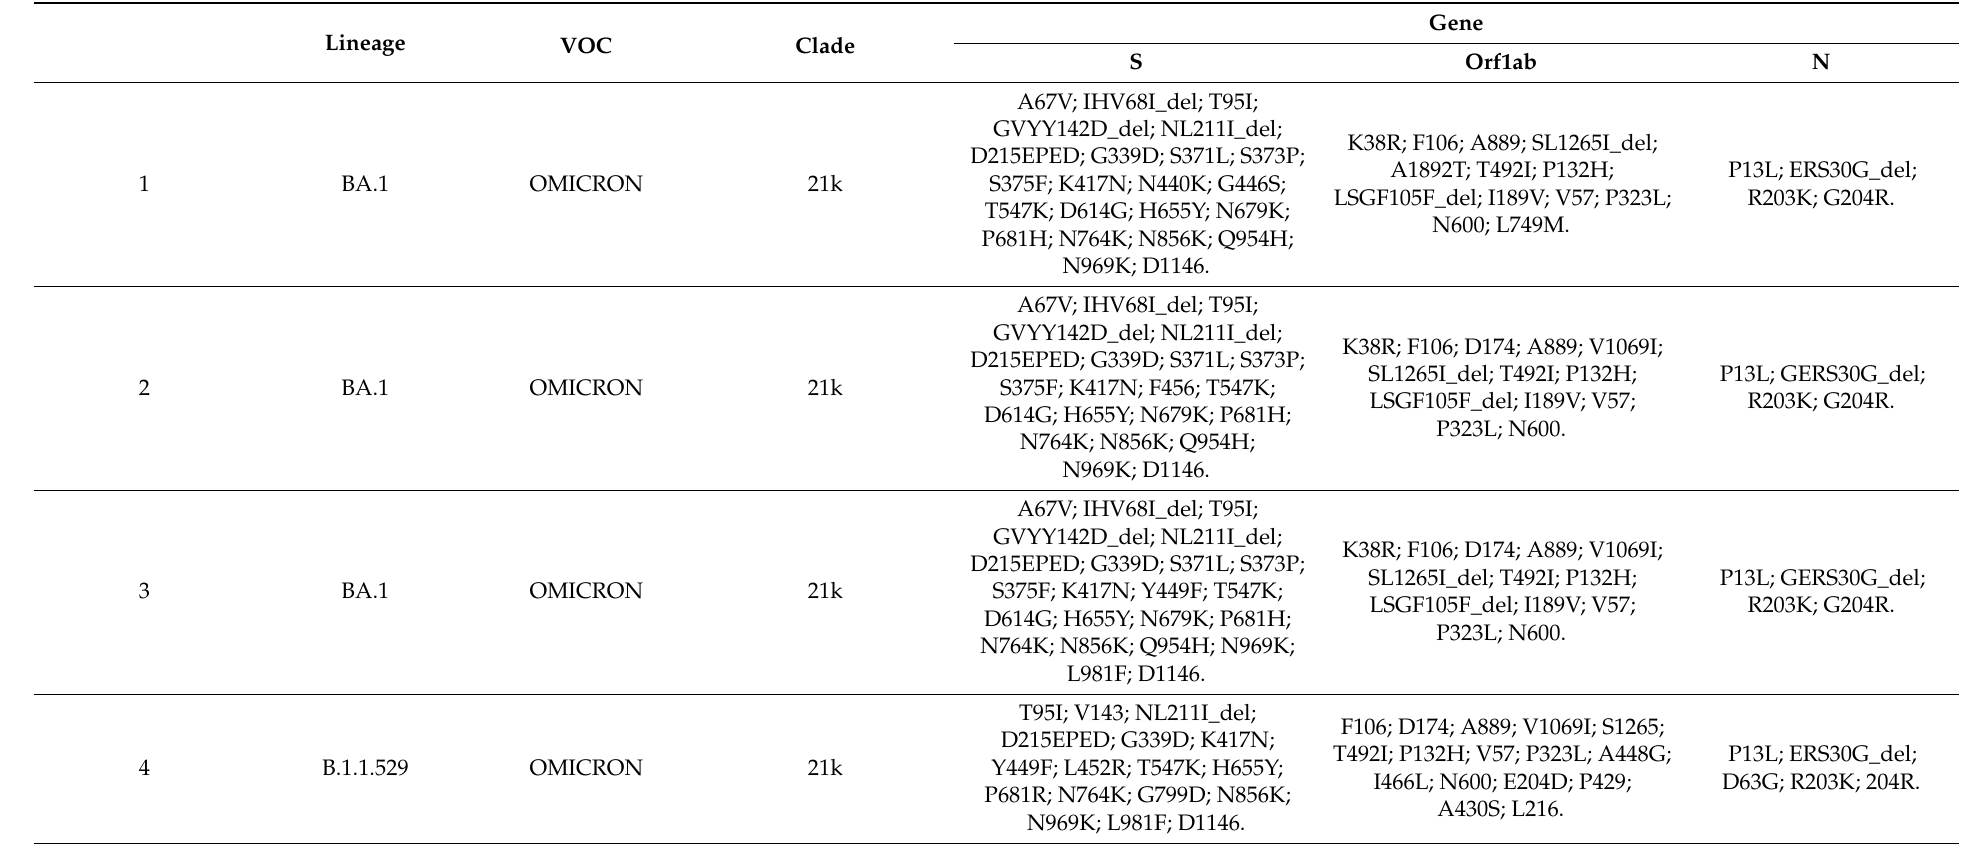
Table 3. NGS sequencing and amino acidic